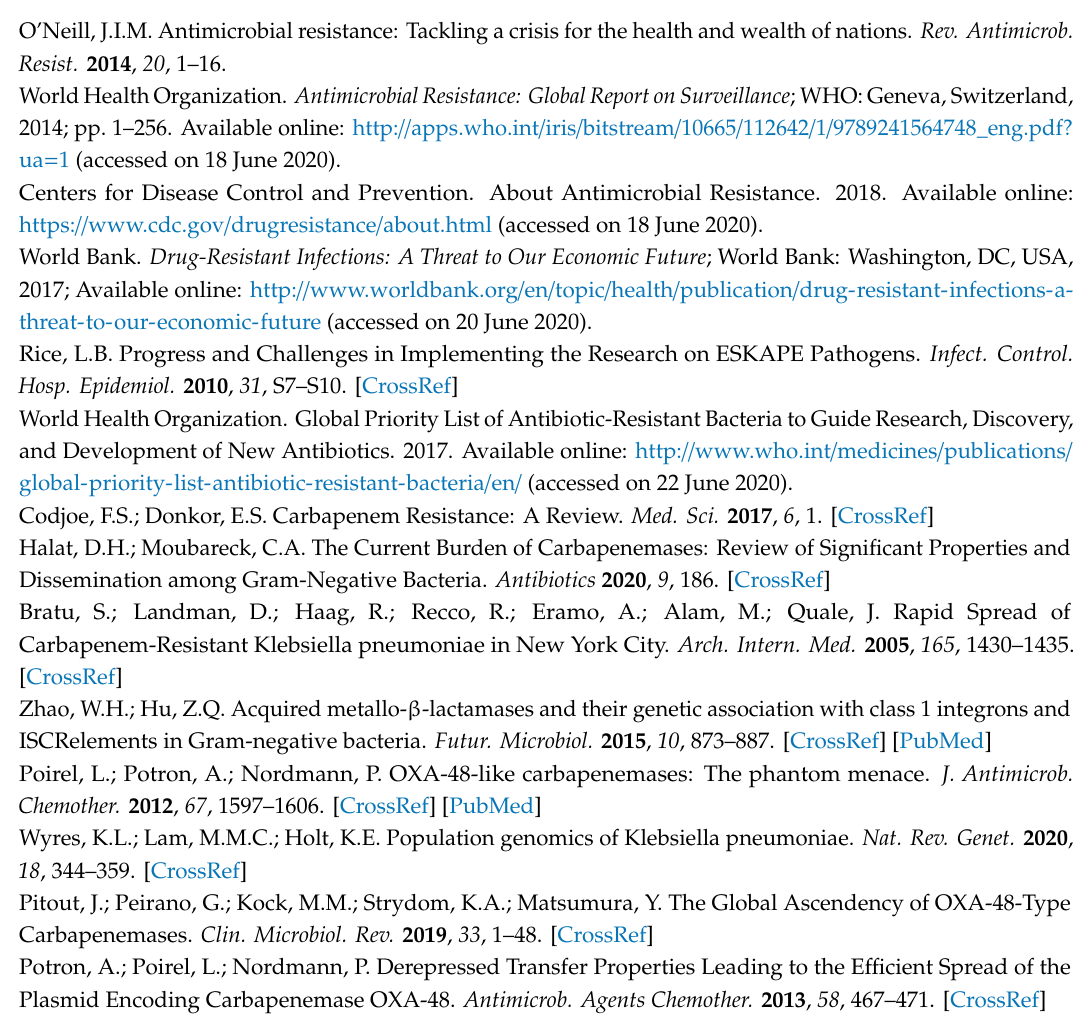
Table S1: Antimicrobial susceptibility patterns of Klebsiella pneumoniae isolates by disc di ff usion method; Table S2: Results of modified Hodge test, inhibitor-based tests, and genotypic detection of investigated carbapenemases; Table S3: Simpson’s Diversity Index calculations for antibiogram; Table S4: Simpson’s Diversity Index calculations for ERIC-PCR; Table S5: Simpson’s Diversity Index calculations for plasmid profile analysis; Table S6: A comparative summary of SDI calculations of the three typing methods; Table S7: Distribution of fimH-1 and mrkD adhesion genes among the carbapenem-resistant isolates; Table S8: The applied antimicrobial agents, their classes, and their interpretive categories; Table S9: Primer sequences and the expected amplicon sizes of investigated